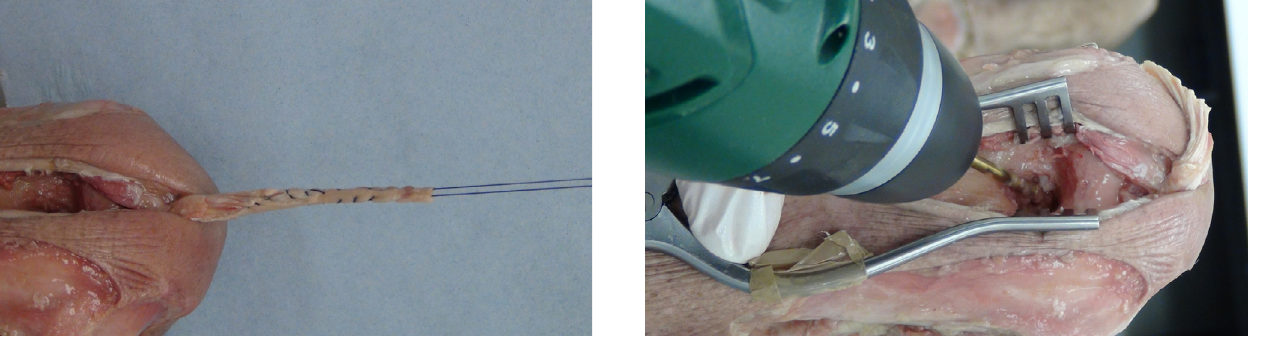
Figure 2. Central strip of triceps tendon harvested and whip stitched.